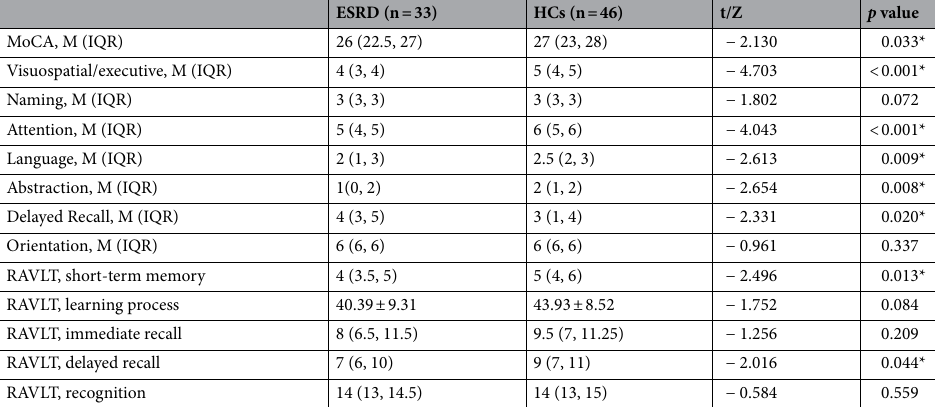
Table 2. Neuropsychological assessment between ESRD and HCs. HC health controls, ESRD end stage renal disease, BMI body mass index, M median, n number, IQR interquartile range, RAVLT Rey auditory verbal learning test. Data are given as mean ± standard deviation (SD), n (%), or M (IQR). *Represents the statistical difference between the two groups, p <